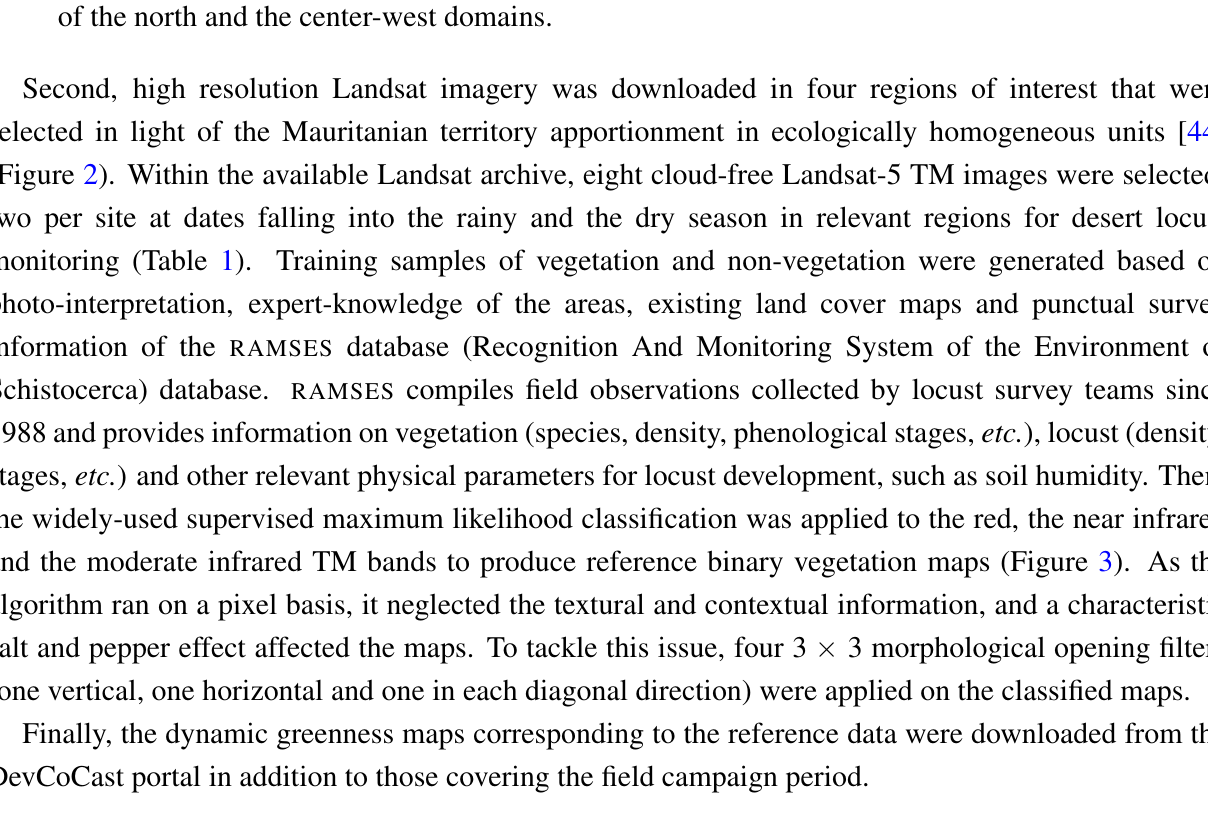
Figure 2. Mauritania and its six ecological domains. Two observations on the four study sites ensure a robust spatial-temporal sampling. Summer breeding areas cover the south domain below the 18th parallel. In the spring and the winter, locusts breed in favorable areas of the north and the center-west